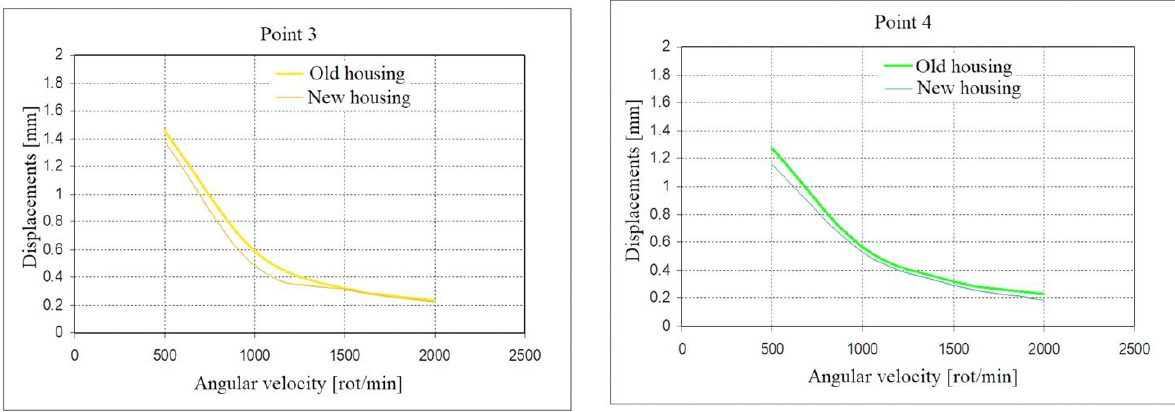
Figure 28. Displacements in measuring points 3 and 4 on the two summing boxes (old and new version).